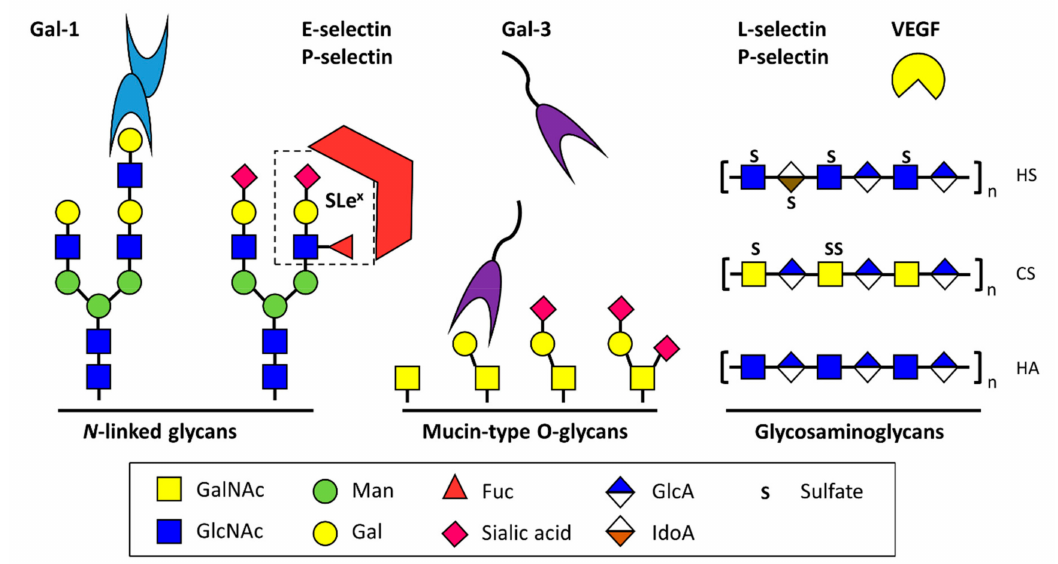
Figure 1. Major classes of glycans and glycosaminoglycans involved in endothelial cell signaling and adhesion. Representative glycan-binding lectins (Gal-1, Gal-3, E-selectin, P-selectin, and L-selectin), growth factors (such as vascular endothelial growth factor, VEGF), and glycoconjugates including N - and O -linked glycans, and glycosaminoglycans, are shown. Abbreviations: HS, heparan sulfate; CS, chondroitin sulfate; HA, hyaluronan; GalNAc, N -acetylgalactosamine; GlcNAc, N -acetylglucosamine; Man, mannose; Gal, galactose; Fuc, fucose; Sialic acid, N -acetylneuraminic acid; GlcA, glucuronic acid; IdoA, iduronic acid; S,